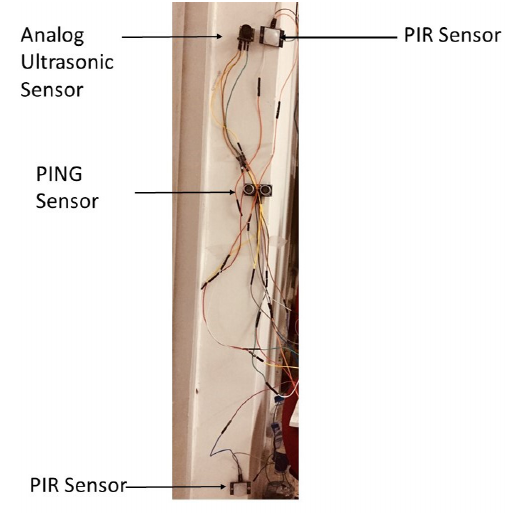
Figure 2. Sensors setup on a wall